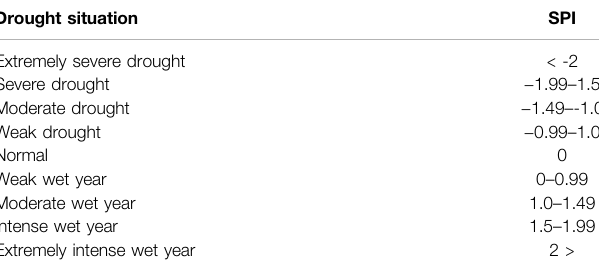
TABLE 2 | Classi fi cation of Standardized Precipitation Index assessment.